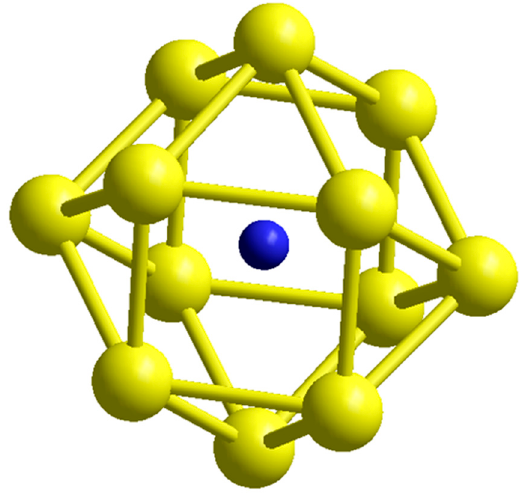
Figure 7. Au 12 H nanosystem, consisting of an icosahedral shell of gold atoms and a central hydro- gen atom.